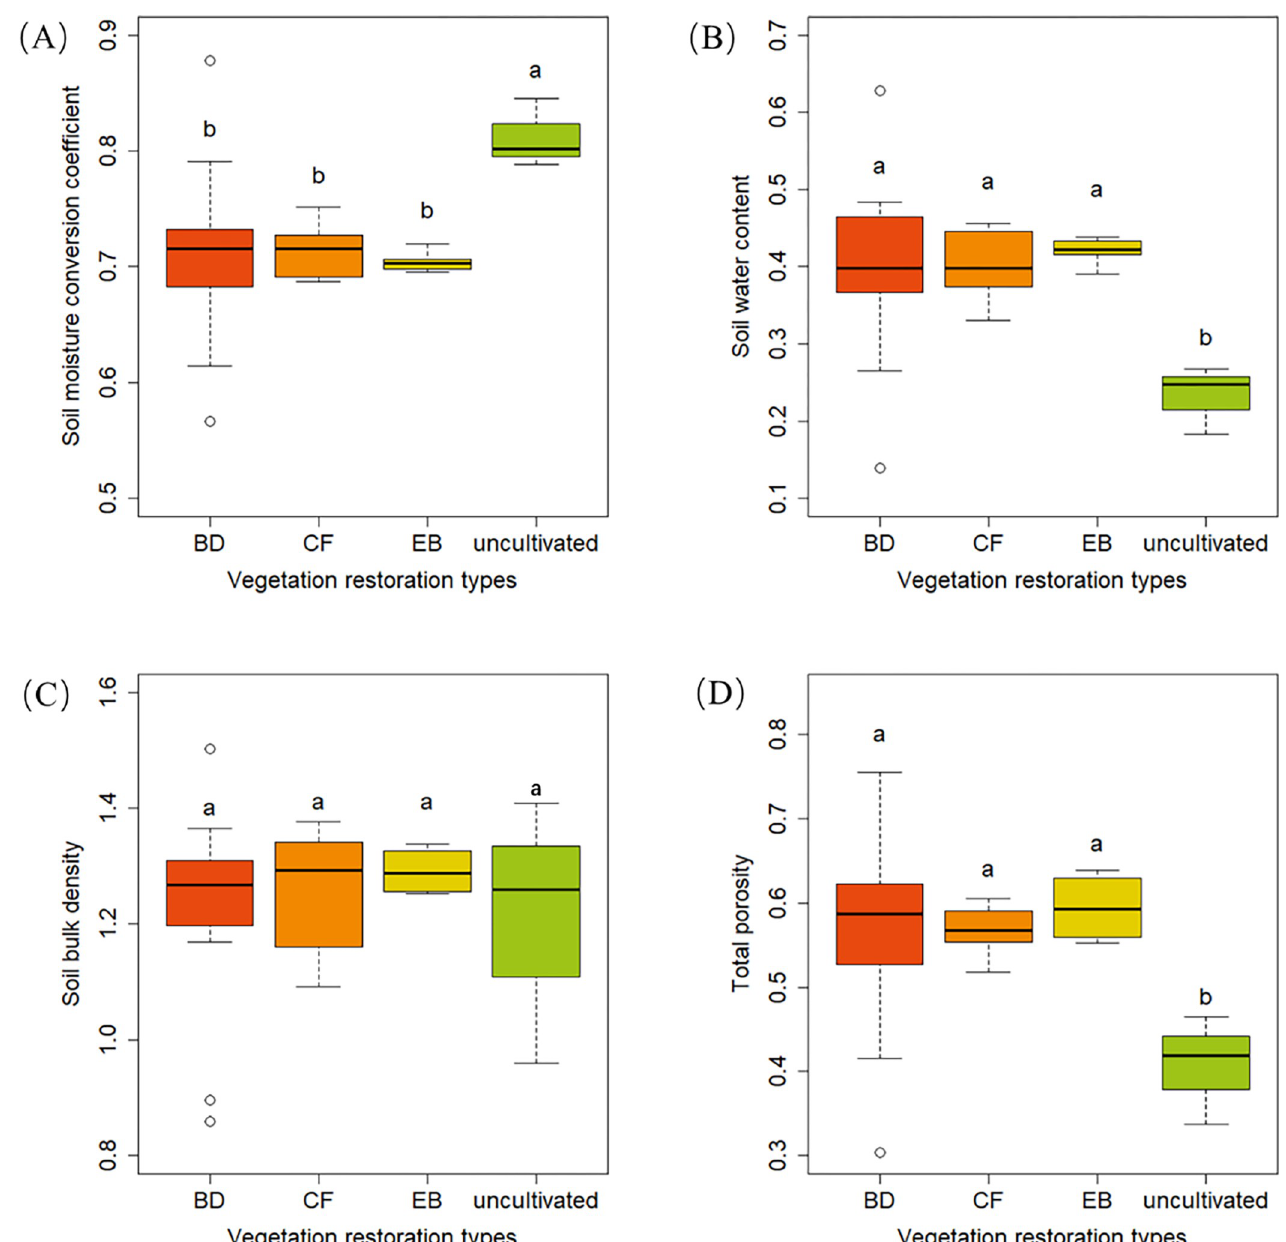
Fig 3. Differences in soil physical properties among different vegetation